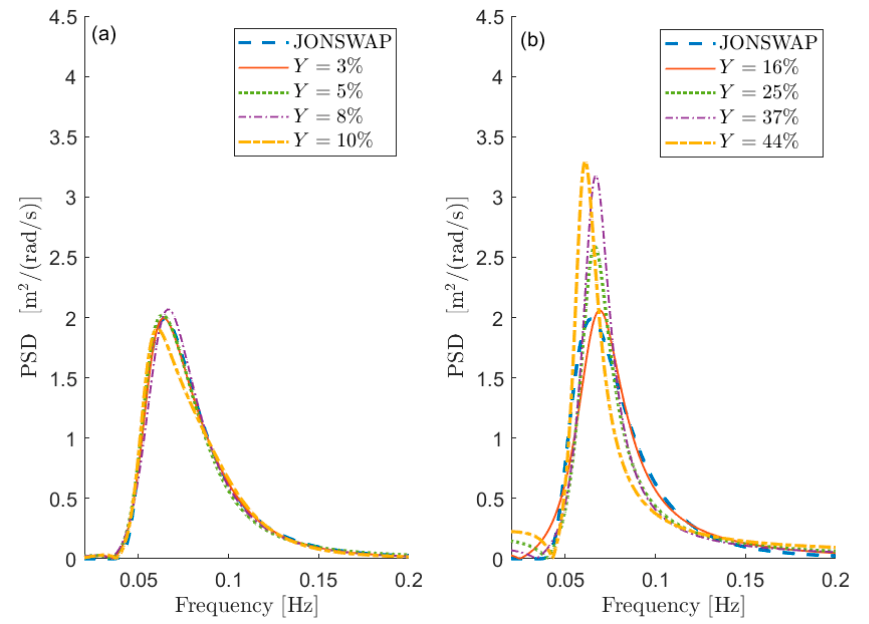
Figure 1. Reconstructed PSD and the corresponding PSD generated with the procedure given in Section 5 (sea state 1 in Table 1) with low ( a ) and larger ( b ) 𝑌 values.